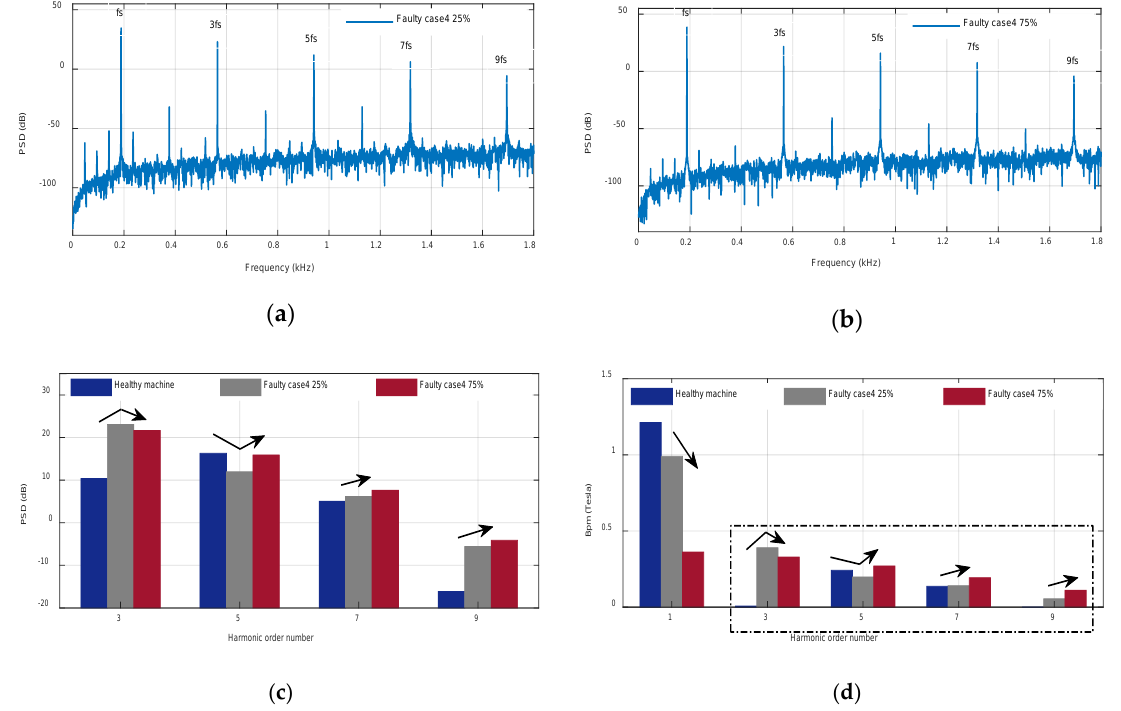
Figure 26. Faulty case 4: ( a ) PMSM current spectra normalized plot under 25%; ( b ) PMSM current spectra normalized plot under 75%; ( c ) ASBCs harmonics variations; ( d ) airgap flux density distribution of harmonics magnitude variations.